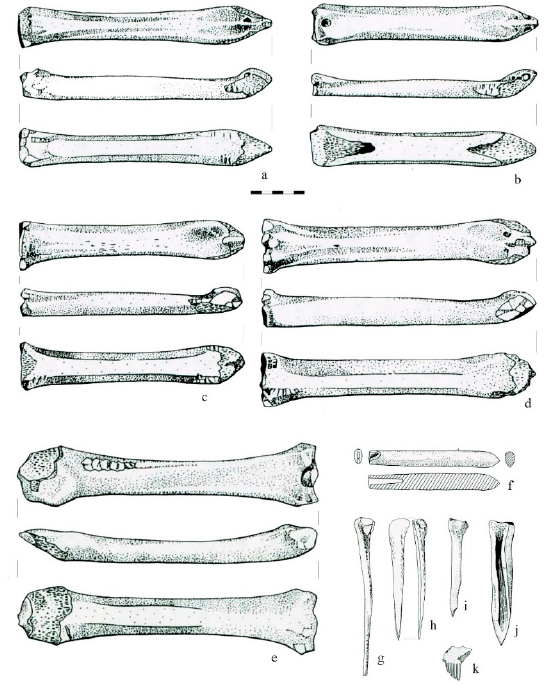
Figure 3. Wroclaw Ostrów Tumski. The selection of horse bone artefacts excavated on the site. Skates ( a – e ), knife handle ( f ), bone spikes ( g – j ), comb ( k ). Raw material: horse metacarpal bone—( a – c , j ); horse metatarsal bone—( d ); horse radius—( e ); horse rib—( f ); horse splint bone (II or IV metapodium)—( g – i ); capsule of hoof—( k ). Figure by Teresa